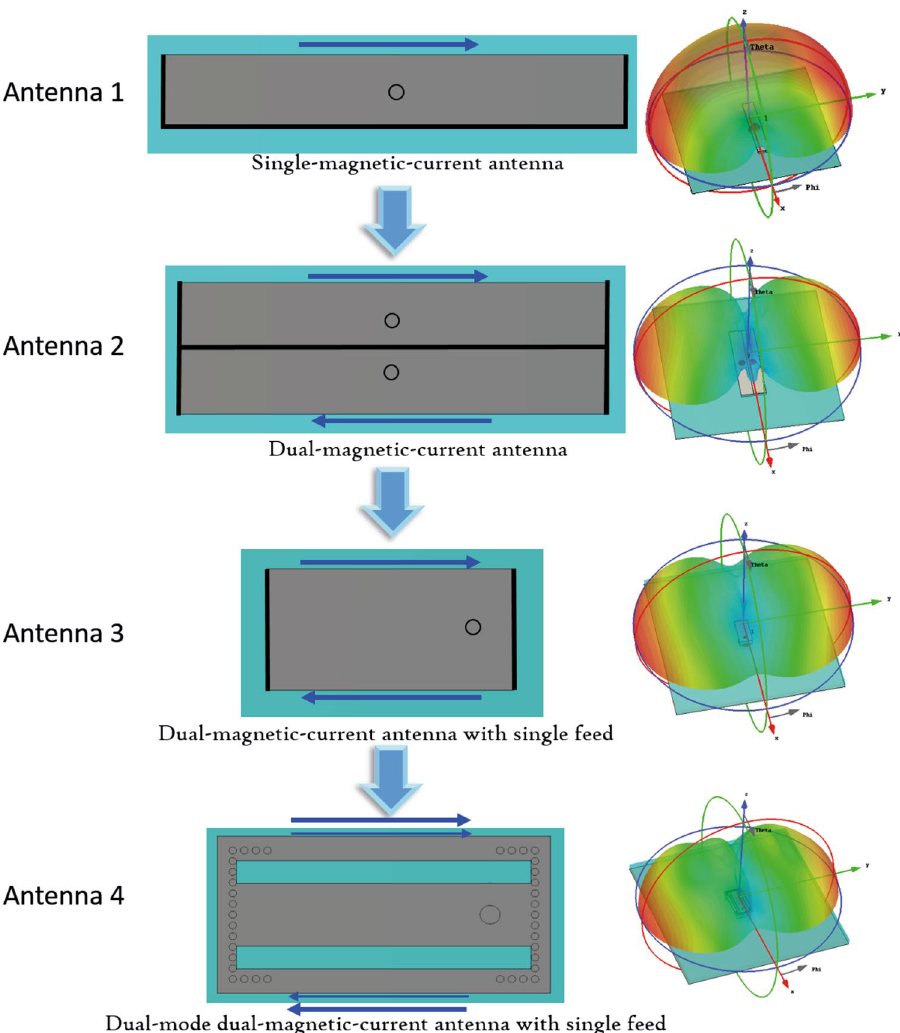
Figure 3. Evolution of magnetic-current antennas. The left column, middle column, and the right column are the names, structure diagrams, and corresponding radiation patterns, respectively. The blue arrows indicate the equivalent magnetic currents. In the simulations, the ground is set to infinite to clearly show performances of radiation patterns and avoid the influence of ground edges. Antenna 1, i.e., single-magnetic-current antenna, has an open edge and three short edges. The slot on open edge can be equivalent to a magnetic current and generate a dipole-like radiation pattern. Antenna 2 is composed of two single-magnetic-current antennas, which are fed with equal magnitude and phase. Two inversed equivalent magnetic currents are generated on the two open edges and the binary magnetic-current array has a bidirectional radiation pattern. Antenna 3 with two open edges and two short edges is a simplified structure of Antenna 2. Antenna 3 has only one feed and the impedance can be matched by adjusting the feed position. Antenna 4 is a practical antenna proposed in this paper. The sheets on short edges of Antenna 3 are replaced with metal grounded holes and two slots are etched on top patch to excite two binary magnetic-current modes and increase the operational frequency